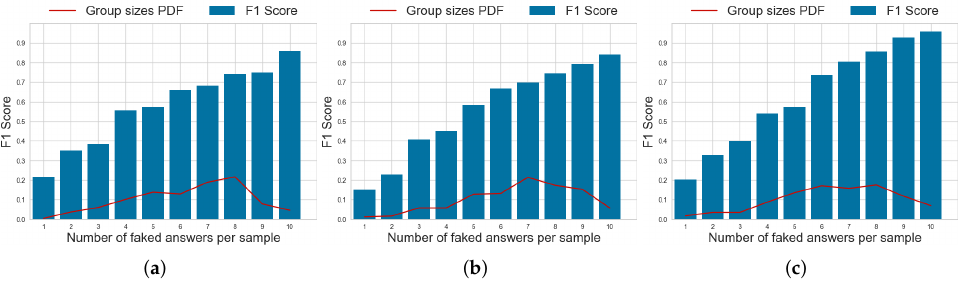
Figure 6. Probability density function (PDF) of the number of faked responses per questionnaire and per-item F1 scores for the faking detection task using the SABA model on different datasets.